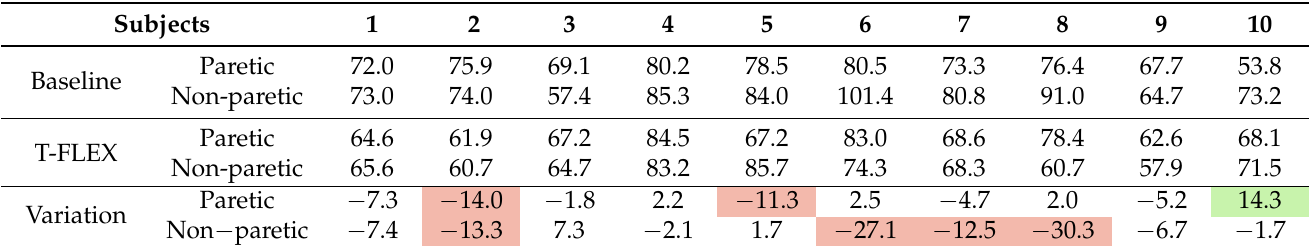
Table 3. Gait Deviation Index for each subject in the baseline and T-FLEX scenarios. The first part is the index for the Paretic (P) and Non-Paretic (N-P) limbs. The lower part indicates the percentage of variation when the participant used the T-FLEX’s actuation system. The highlighted values denote deviation above 10% for both increases (green) and decreases (red).